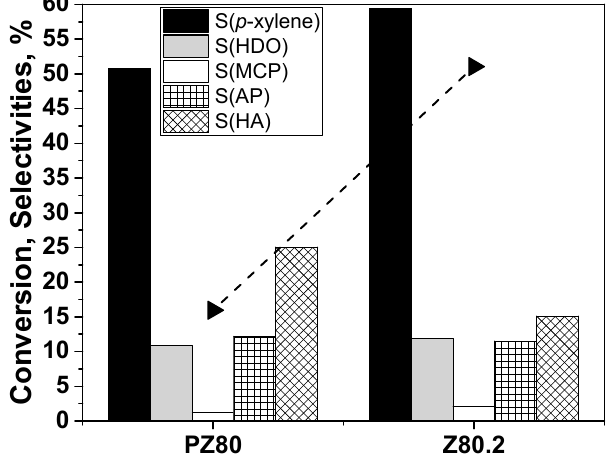
Figure 10. Conversion (X, symbol + line) and selectivity (S, columns) values for untreated PZ80 and treated Z80.4. Conversion (triangle), S( p -xylene) (black), S(2,5-hexanedione) (HDO, grey), S(3-methyl-2-cyclopentenone) (MCP, white), S(alkylated products) (AP, square pattern) and S(higher aromatics) (HA, diagonal pattern). Reaction conditions: 250 °C, 55 bar total pressure (pressurised at 250 °C), 5.5 mL DMF, 0.45 mL tridecane (internal standard), 16.5 mL hexane, 110 mg catalyst, 20 h. The carbon mass balance was in all cases >95%.